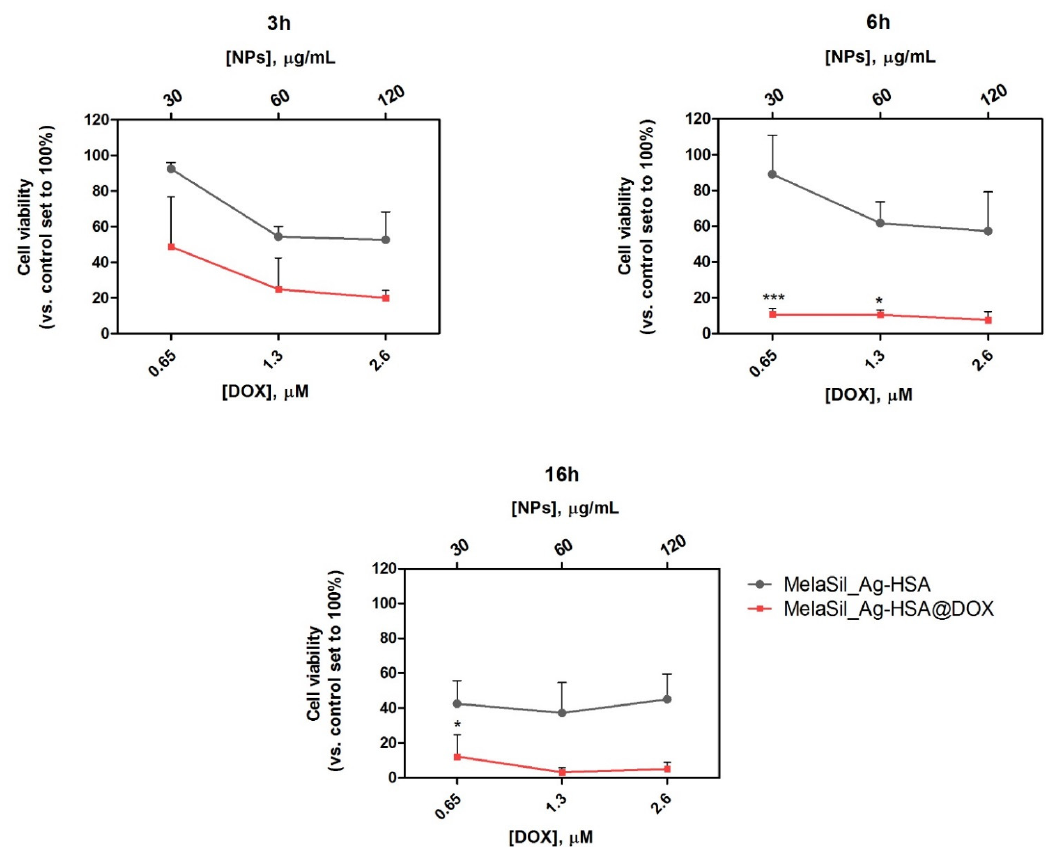
Figure 7. Cell viability of HS578T following 808 nm CW laser irradiation. Cells treated for 3 h, 6 h, and 16 h with MelaSil_Ag-HSA@DOX NPs (red) or MelaSil_Ag-HSA NPs (gray) at the concentrations of 30, 60, and 120 µg/mL (upper X axis), corresponding to 0.65, 1.3, and 2.6 µM DOX, respectively, for DOX-loaded NPs (lower X axis) and irradiated for 5 ′ . * p < 0.05 and *** p < 0.001 versus cells treated with MelaSil_Ag-HSA. CellTiter-GLO assay was performed 24 h after irradiation.